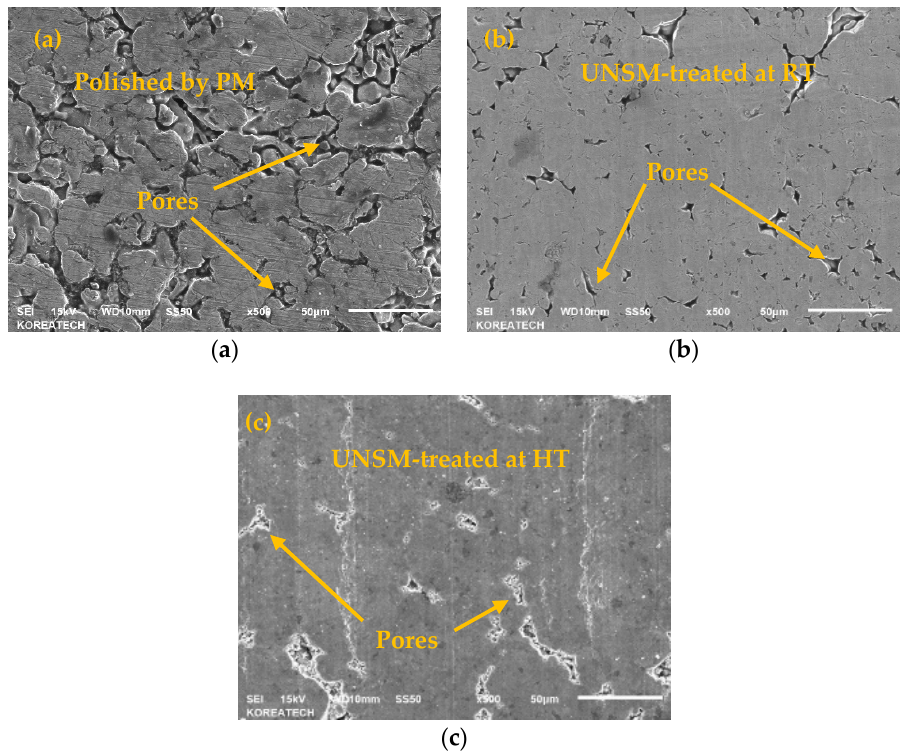
Figure 3. SEM images of the as-PM ( a ), UNSM-25 ( b ) and UNSM-300 ( c ) samples showing surface morphology.